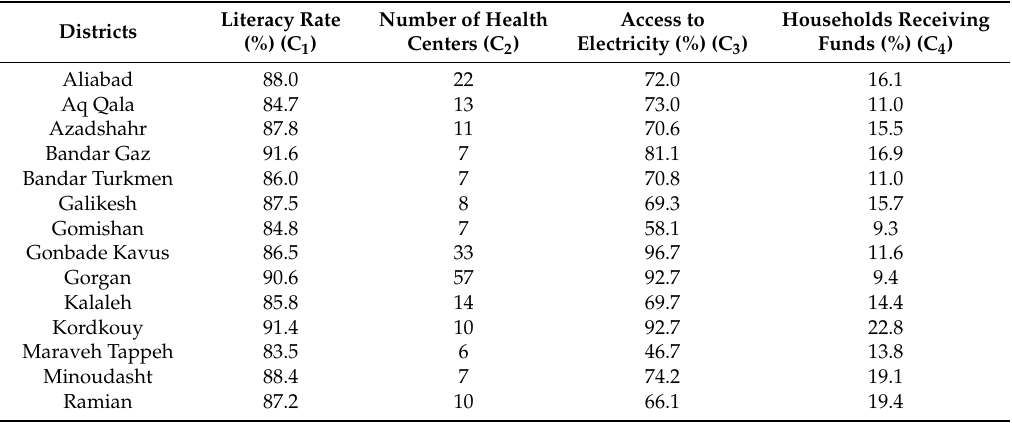
Table 5. The status of the “Capacity” component in different districts of Golestan Province.